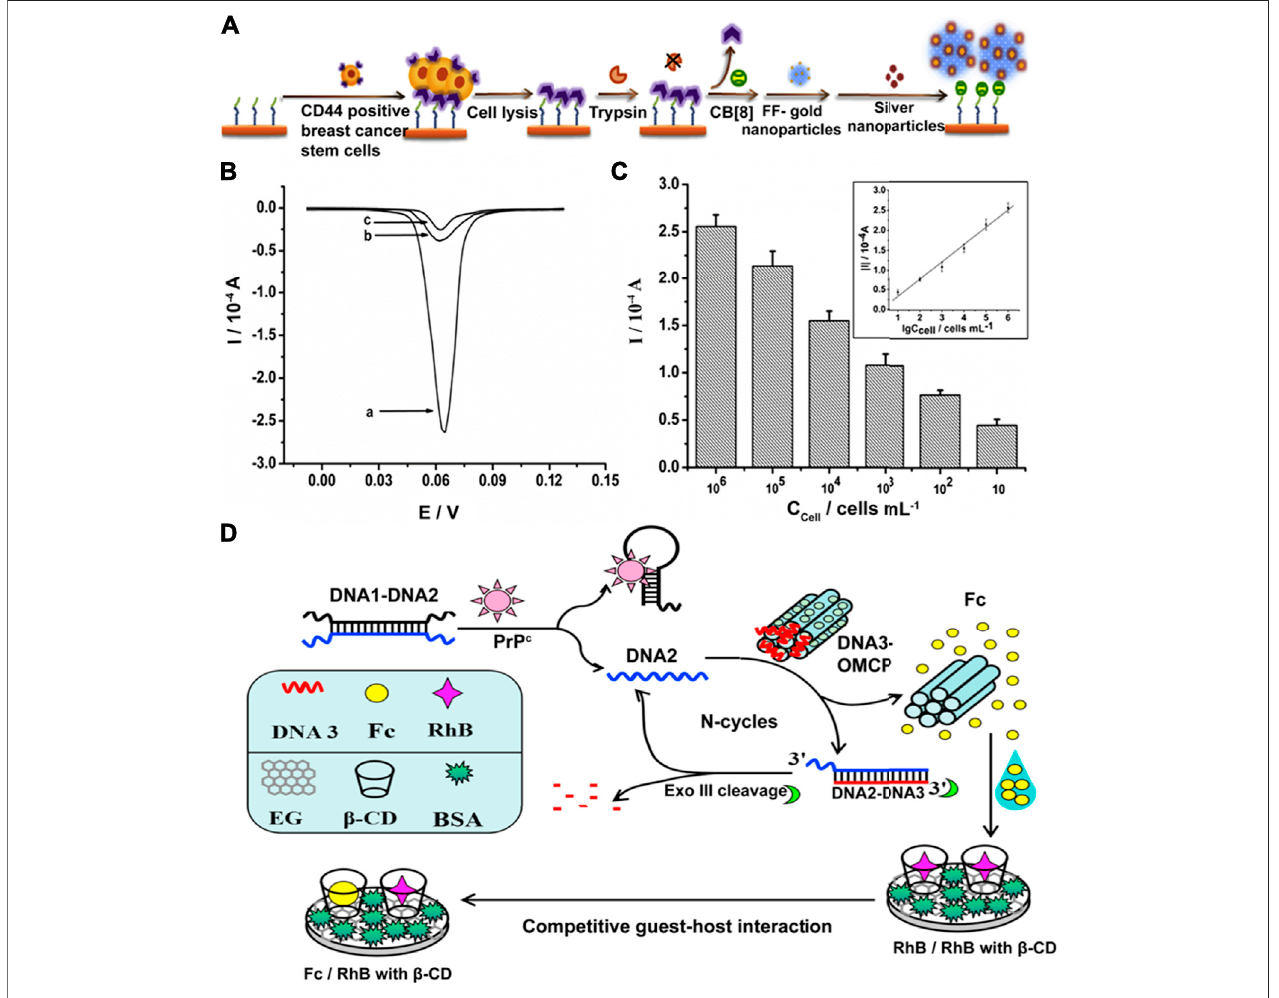
FIGURE 7 | (A) Schematic illustration of detection of CD44 in cell samples. (B) Linear sweep voltammetry scans obtained in the presence of CD44-positive breast cancer stem cells (BCSCs) (curve a), CD44-negative cell BT474 (curve b) or in the absence of cell samples (curve c). (C) Peak currents obtained in different concentrations of BCSCs. Inset shows a linear relationship between the absolute value of the peak current and the logarithm of cell concentration from 10 cells/mL to 10 6 cells/mL. Figures are adapted from (Zhao et al., 2018). (D) Schematic illustration of the label-free and cascaded dual-signaling ampli fi ed electrochemical strategy for cellular prion protein detection. Figure is adapted from (Yu et al., 2016b). Copyright 2016, 2018 Elsevier.